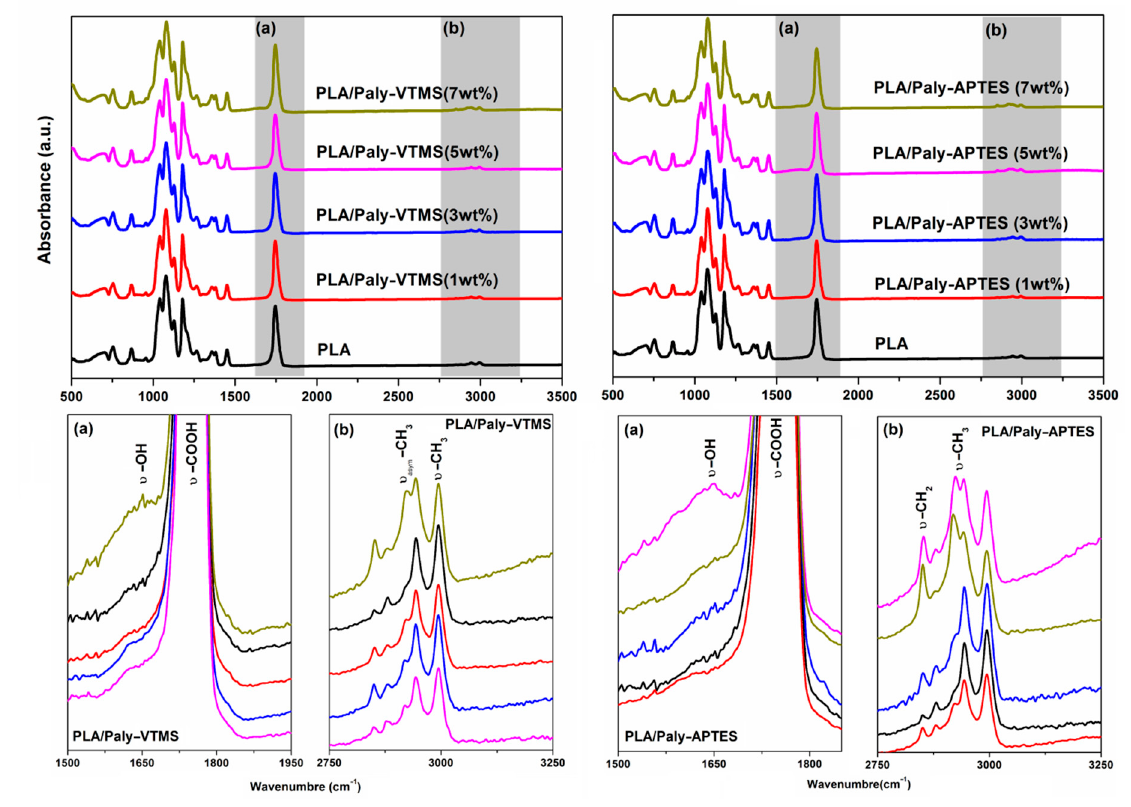
Figure 3. FTIR spectra of PLA, PLA/Paly-VTMS, and PLA/Paly-APTES for wavenumber (cm − 1 ) ranges: ( a ) 1500–1950 and ( b ) 2750–3250.